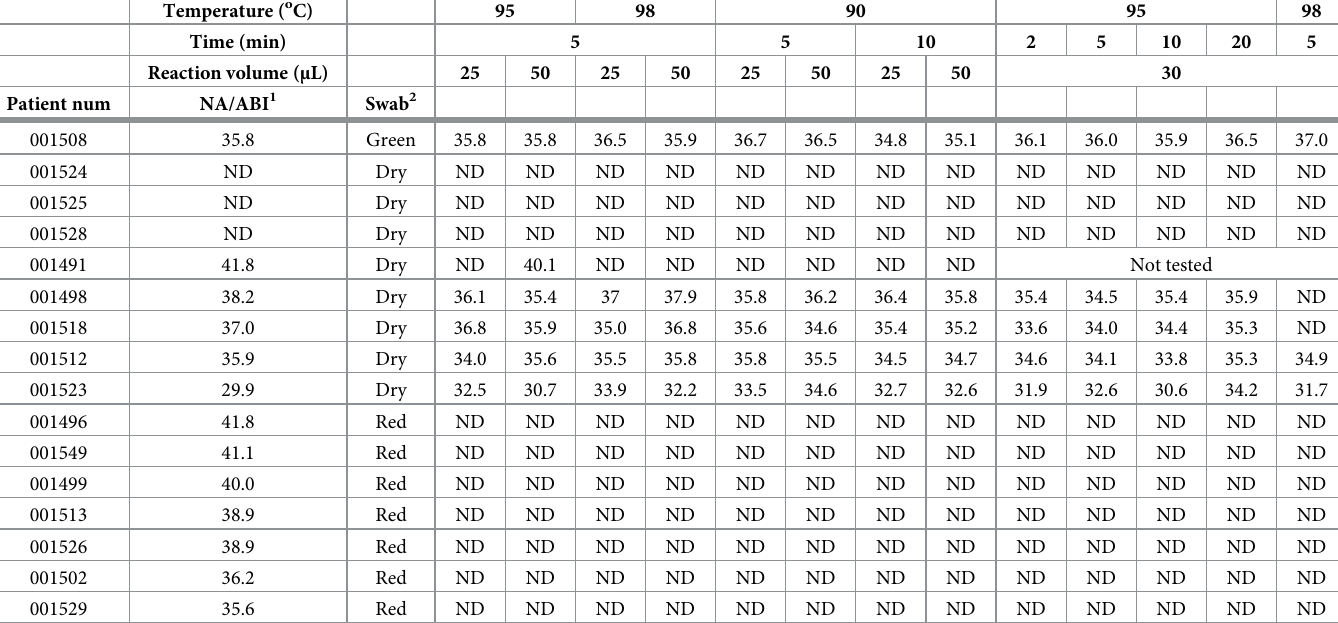
Table 1. Optimisation of heat-induced sample preparation for SARS-CoV-2 testing targeting the N-gene and using the TaqMan 1 Fast Virus 1-Step RT-qPCR kit from ABI. Temperature ( o